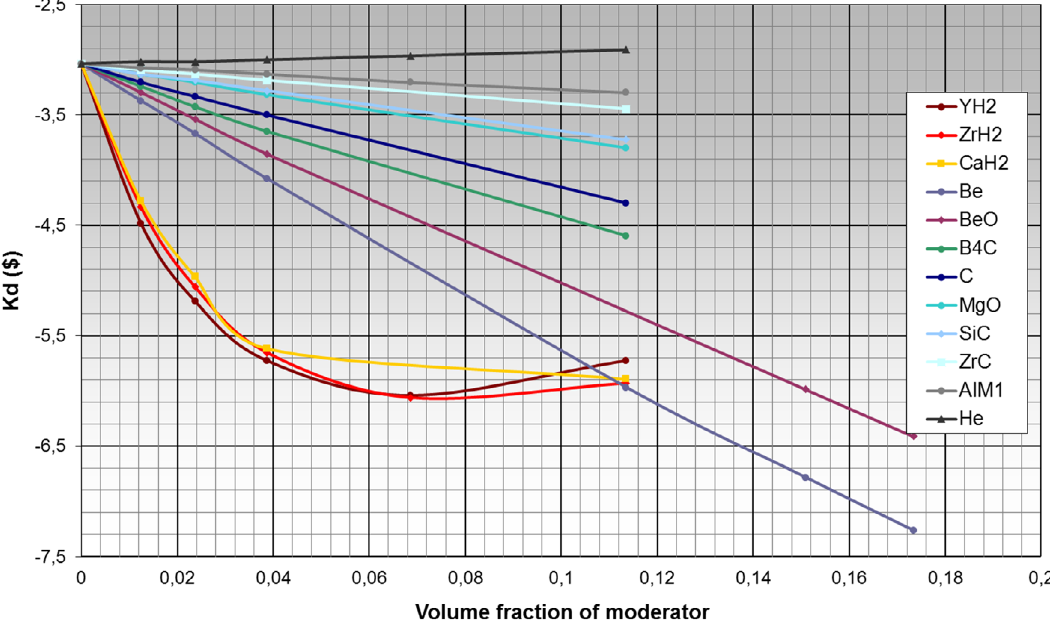
Fig. 1. K Doppler for different types of moderators as a function of their core volume